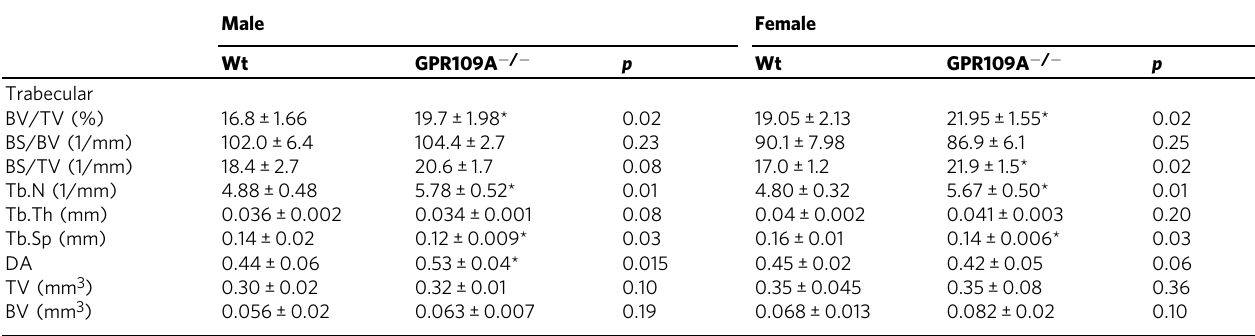
Table 1 Micro-CT parameters on vertebra of wild type and GPR109A-/- male and female mice. Male